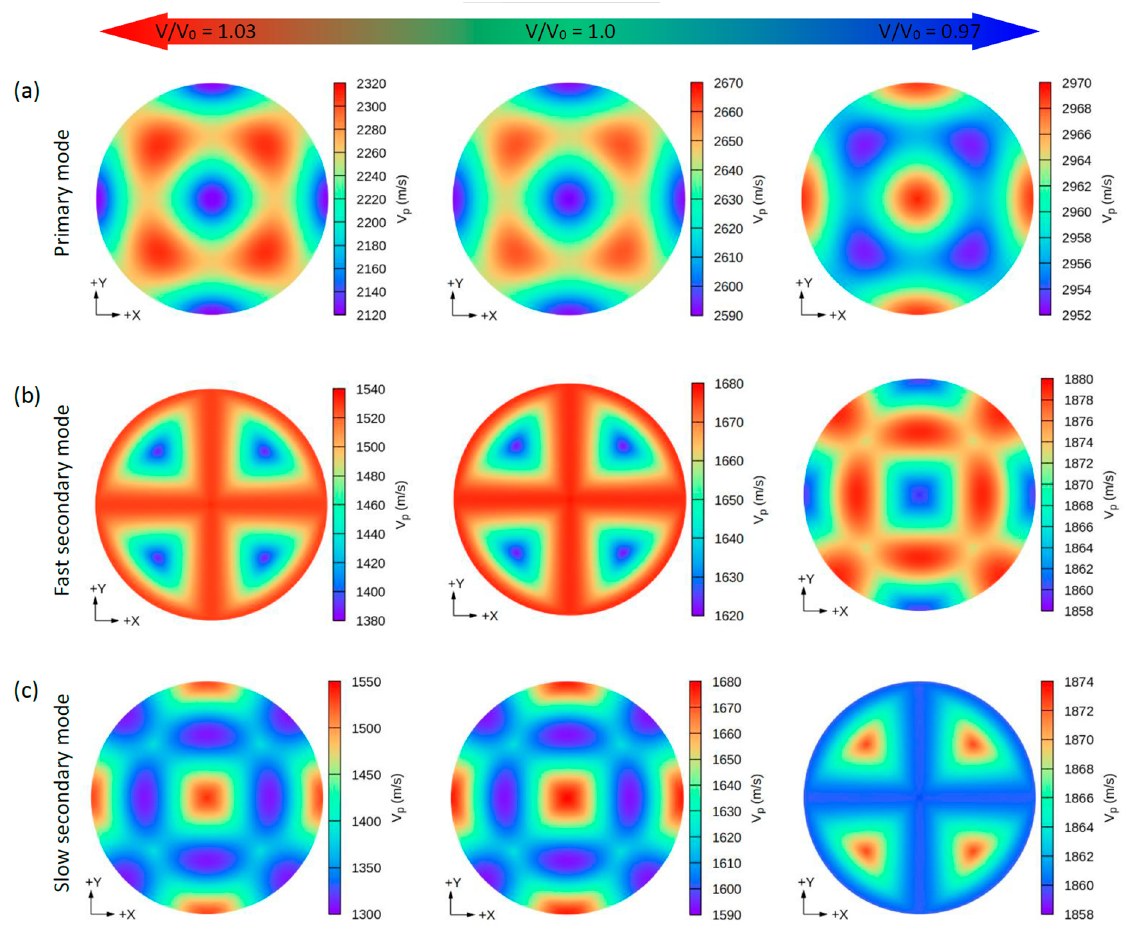
Figure 4. The calculated 2D directional dependence of the phase wave velocity (V p ) in (xy)/(001)-plane for CsNa 2 Bi. There are two types of acoustic wave velocities, i.e., the longitudinal wave velocity and the transverse wave velocities in two directions. The single primary mode ( a ) is the longitudinal wave velocity, and the two secondary modes, namely, fast secondary ( b ) and slow secondary ( c ), correspond to the transverse wave velocities. Although under hydrostatic tension no changes are observed in the propagation patterns of V p , in hydrostatic compression, these patterns change